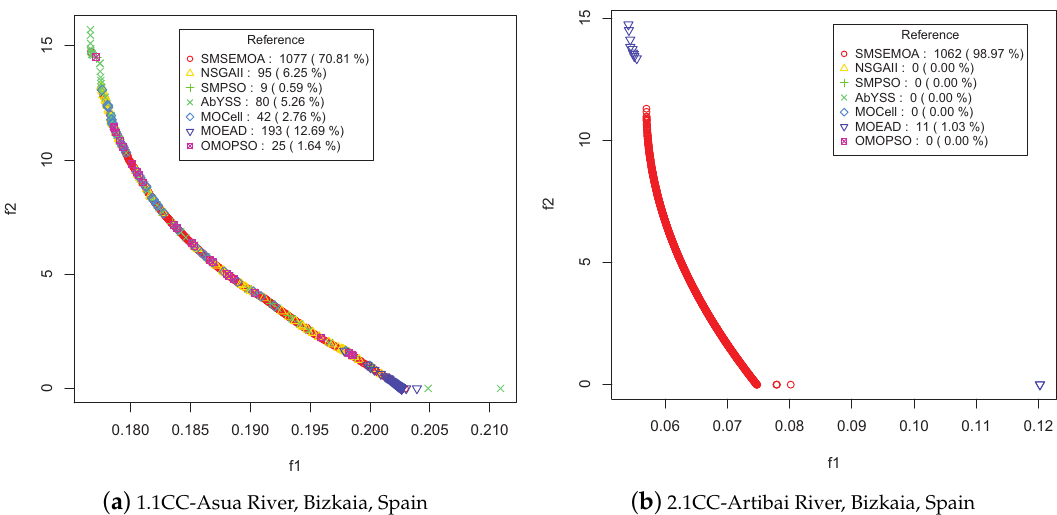
Figure 4. Reference Front approximations obtained by evaluated algorithms for Spanish river instances. The contribution of each algorithm (calibrator) to the reference front are computed in terms of percentage and number of non-dominated solutions.